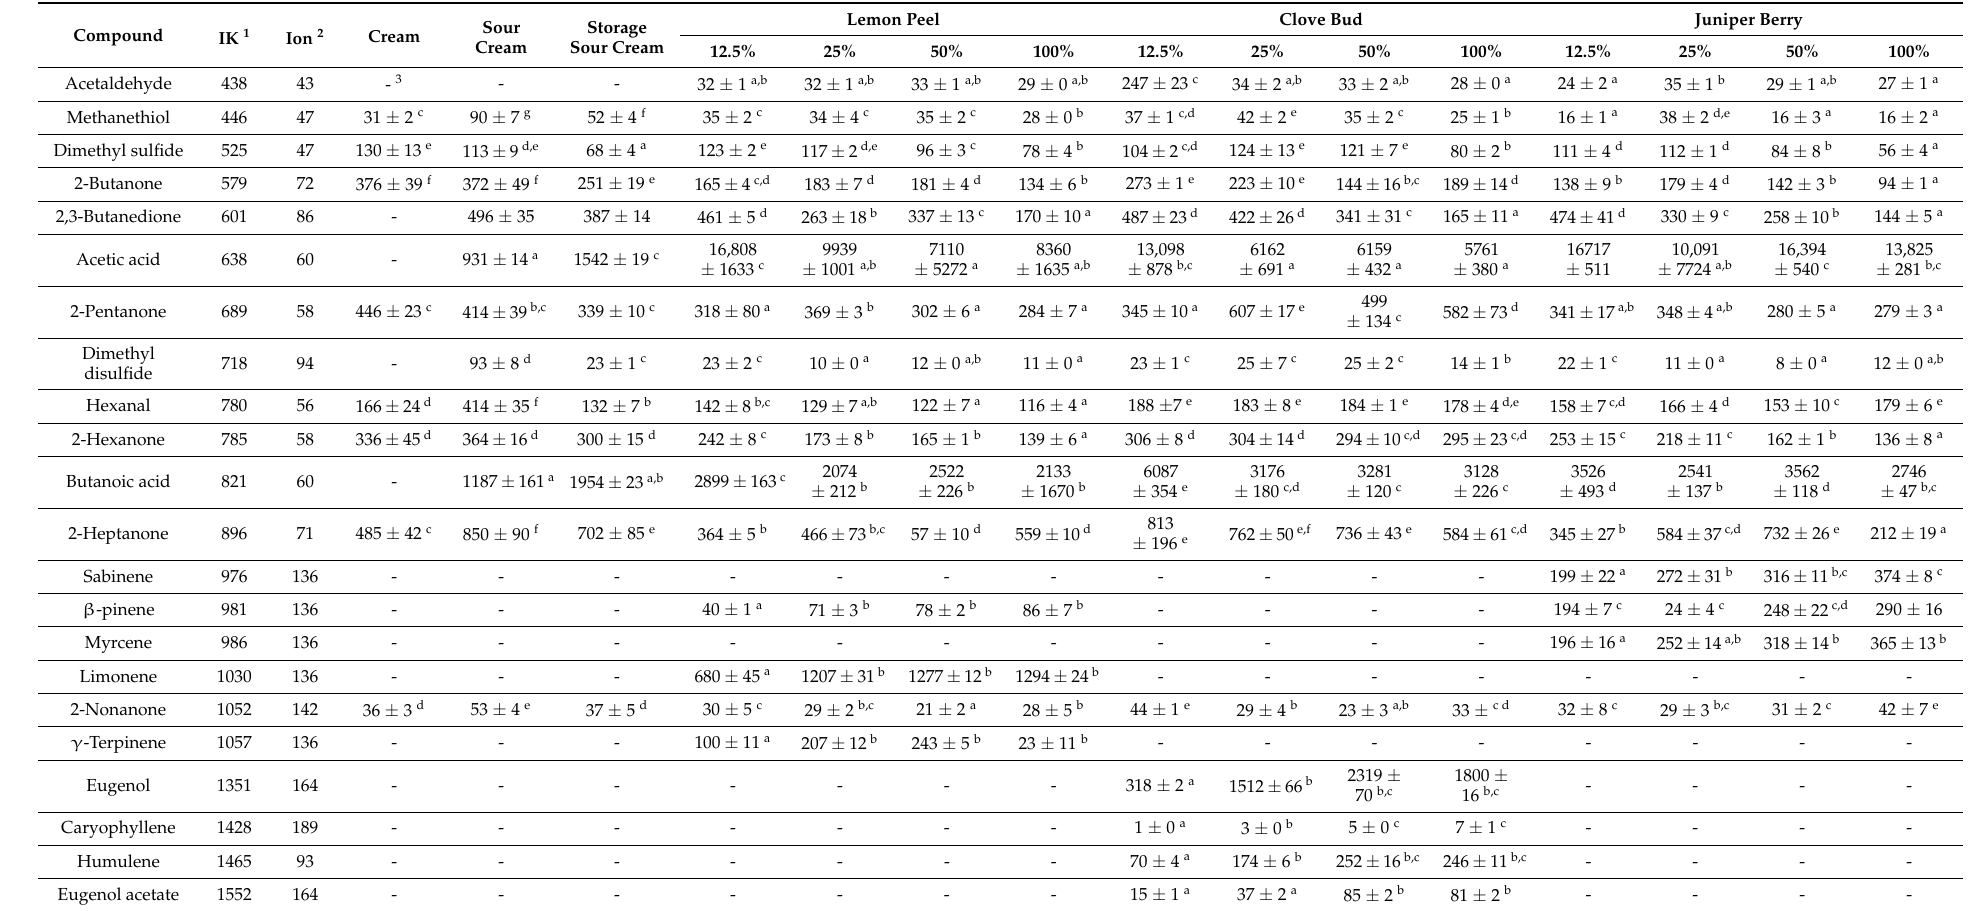
Table 4. Volatile compounds identified in cream samples using SPME-GC–TOF-MS